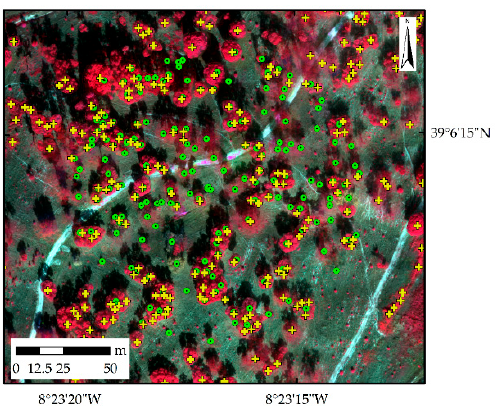
Figure 5. Individual tree location obtained using the developed algorithm (yellow cross) and Figure5. Individualtreelocationobtainedusingthedevelopedalgorithm(yellowcross)andcoordinated coordinated at the field (green circles) for site HMG. at the field (green circles) for site